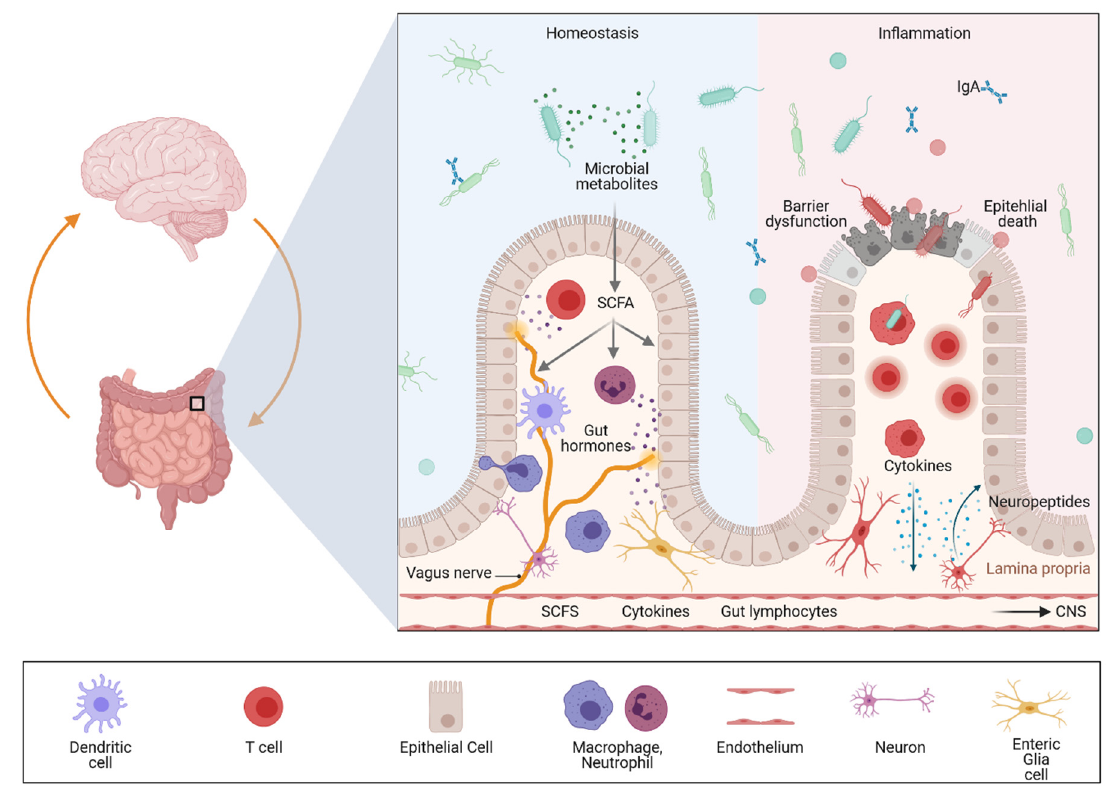
Figure 1. Impact of intestinal inflammation on gut–brain communication. The figure was generated with biorender.com (8 July 2021). Multiple pathways exist through which gut–brain communication can be modulated including neural, hormonal, metabolic, immunological, and microbial signals. Signaling events from the gut can modulate brain function, and recent evidence suggests that a dysregulated gut–brain axis plays a pivotal role in linking gastrointestinal and neurological diseases involving neuroinflammation as well as neurodegeneration. Cytokines released by the mucosal immune system in response to local inflammation or infection can be released in the periphery reaching the CNS via the bloodstream. Similarly, circulating gut-primed immune cells can cross the blood–brain barrier (BBB) and modulate immune responses in the CNS. In addition, bacterial metabolites, such as short-chain fatty acids (SCFAs) are neuroactive metabolites of dietary fibers that can further influence gut–brain communication and neuroinflammation. In addition to immune signals and microbial metabolites, signaling from the vagus and enteric nervous system affect gut mucosal and anatomically distant tissues such as the CNS. These peripheral signals promote neuroinflammation and